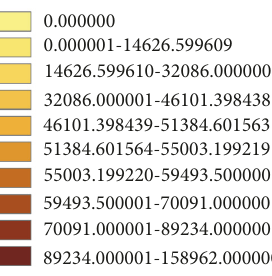
Figure 4: Distribution of the product of the population and mean probability on the township